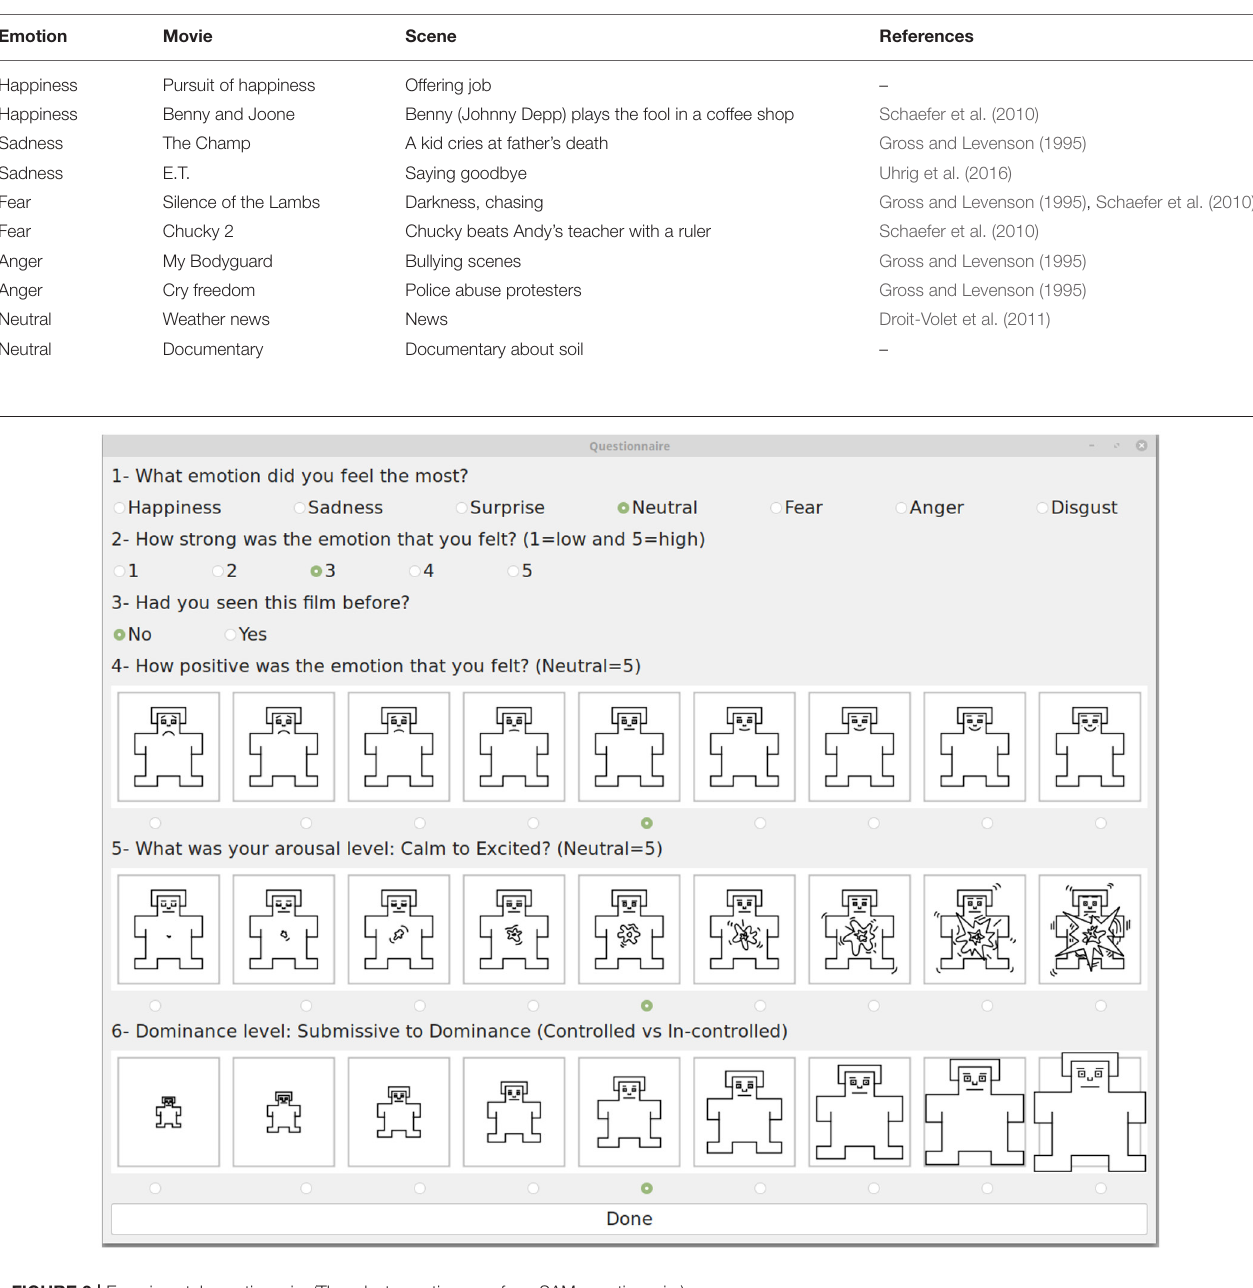
FIGURE 3 | Experimental questionnaire (Three last questions are from SAM questionnaire).